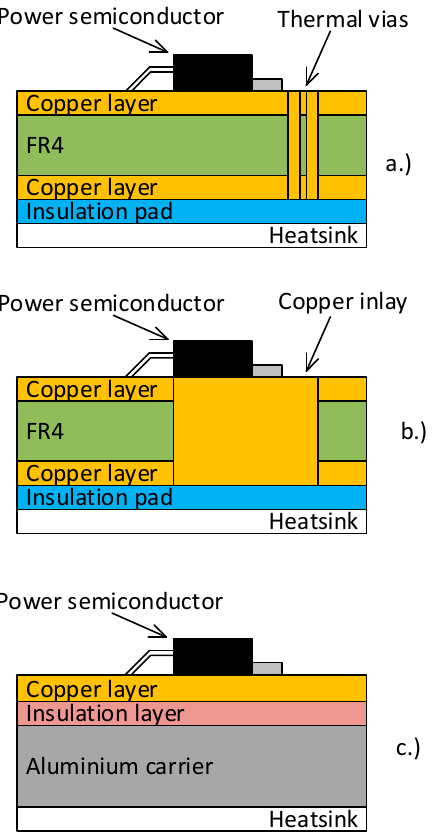
Figure 2. PCB Heat dissipation solution: ( a ) thermal vias; ( b ) copper inlay; ( c ) IMS board.